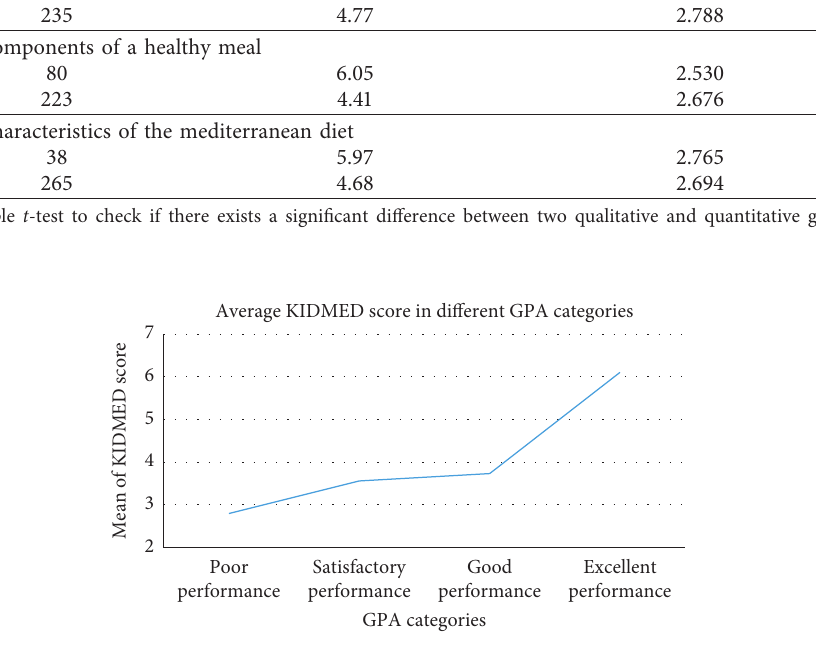
Figure 1: The average of KIDMED score of students in poor and high adherence to MD categories with respect to GPA categories. GPA: Grade Point